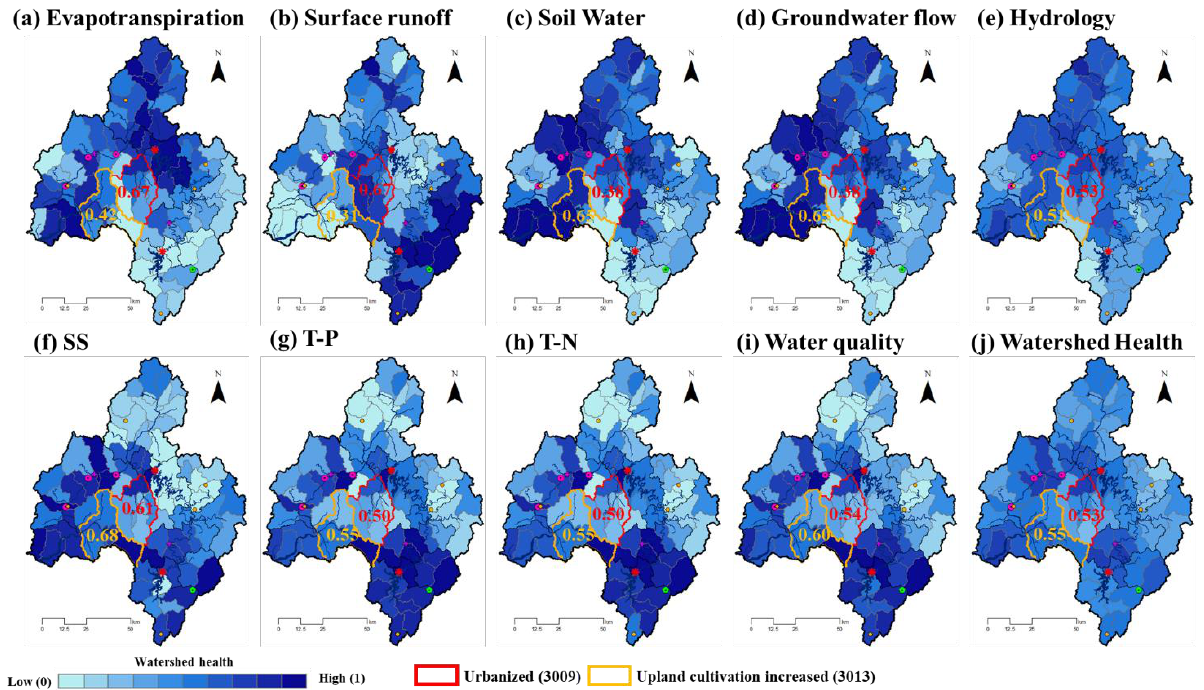
Figure 5. Hydrology and water quality results of the WHI in reference year.